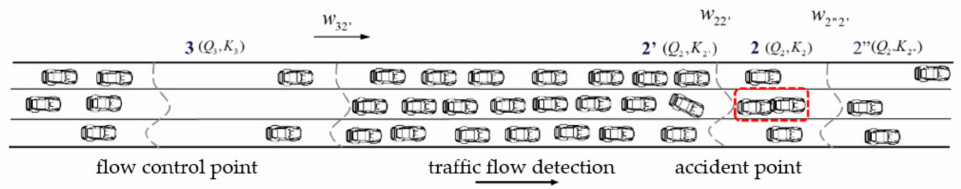
Figure 6. Diagram of flow–density after traffic control in the extra-long tunnel.